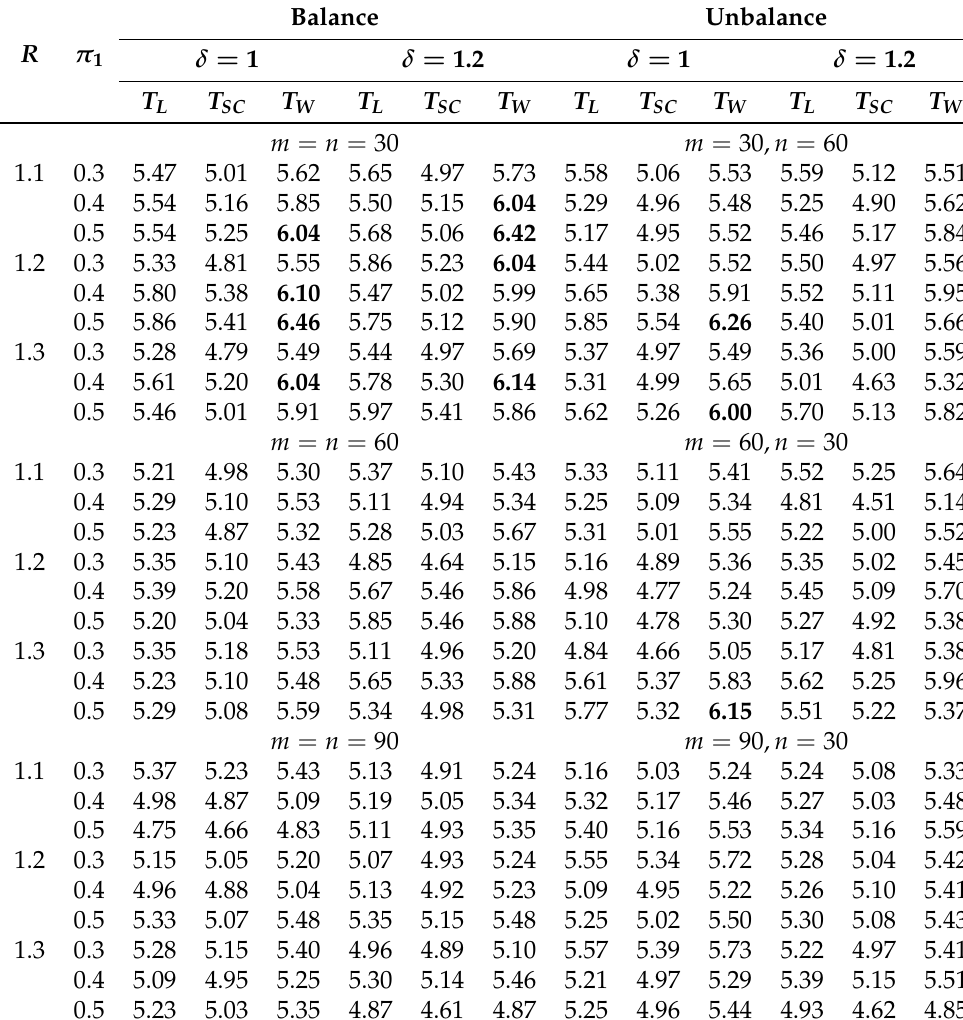
Table 3. The empirical TIEs (%) of tests under H 0 : δ i = δ ( g = 3, α = 0.05). Balance Unbalance R π 1 δ =